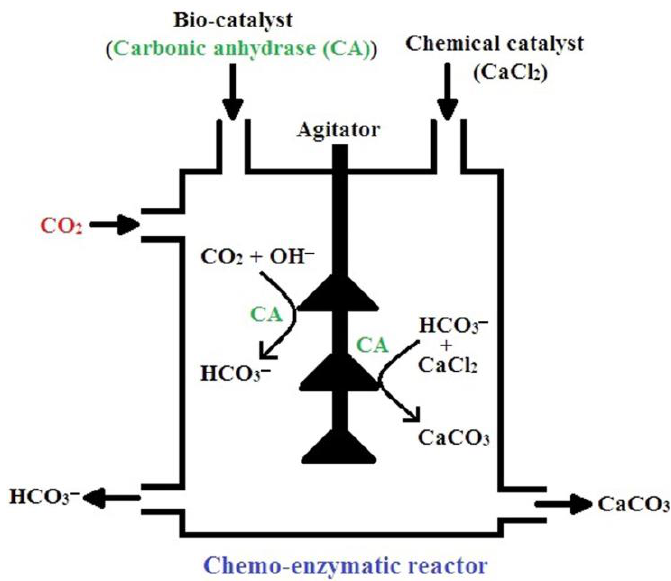
Figure 9. Chemo-enzymatic CO 2 utilization and conversion [27]. Reproduced with permission from Elsevier 2021.